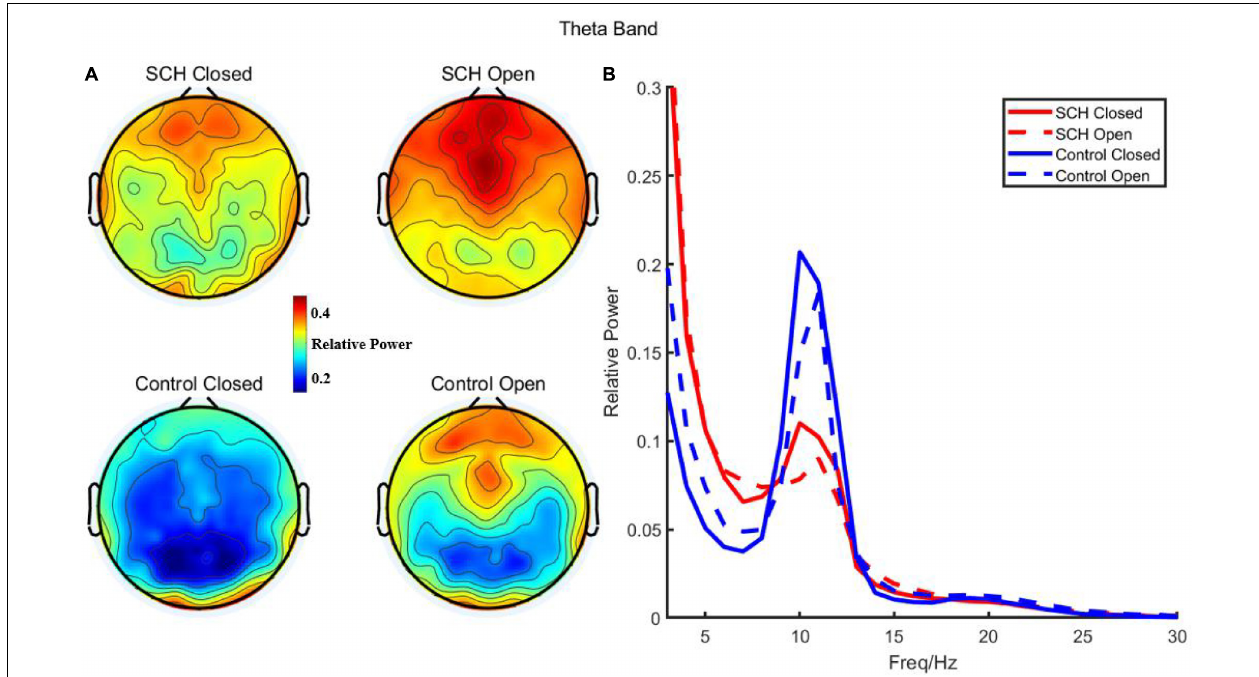
FIGURE 1 | (A) Relative power of theta in schizophrenia and control with eye closed and eye open. (B) Relative power and frequency in schizophrenia and control with eye closed and eye open (channel 72).